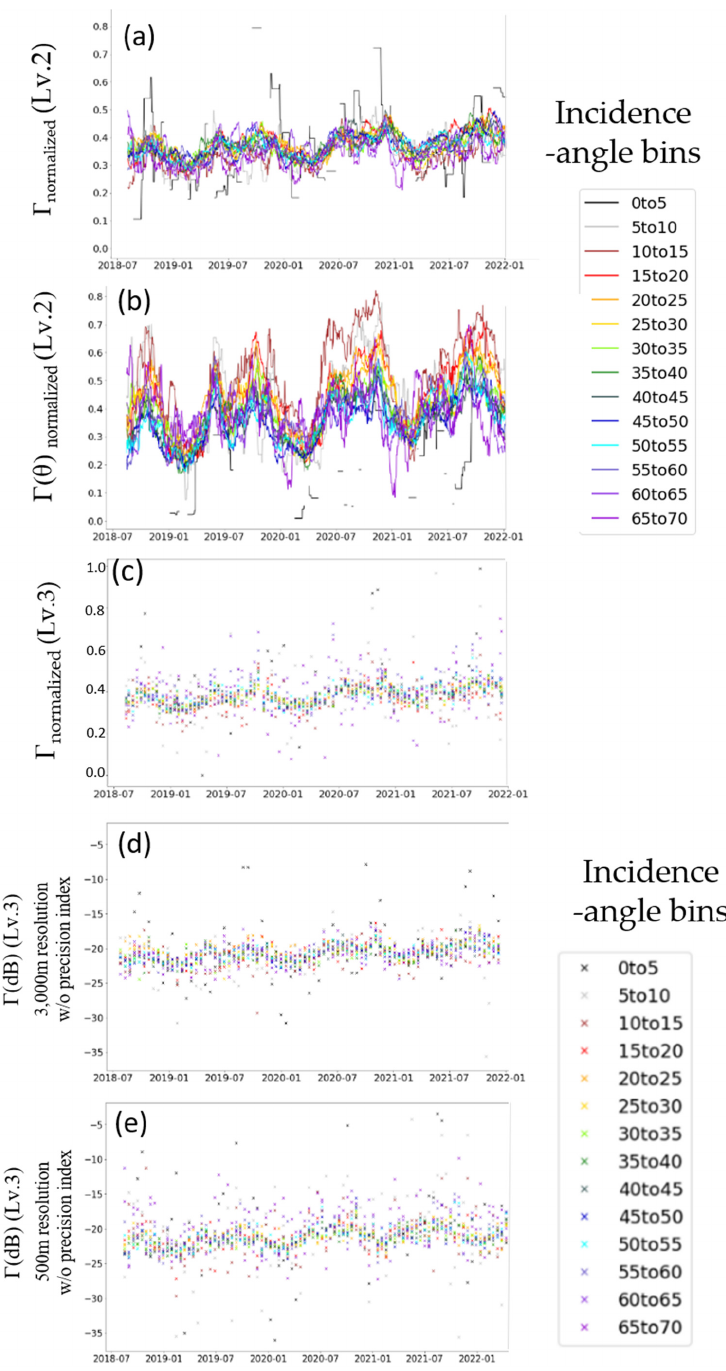
Figure 6. Temporal dynamics of the Lv. 2 daily product with a 30-day moving average (( a ): Γ normalized and ( b ): Γ ( θ ) normalized ) and the Lv. 3 15-day-cycle Kalman smoother product [( c ): Γ normalized (500 m resolution with the precision index), ( d ): Γ (3000 km resolution without the precision index) and e: Γ (500 m resolution without the precision index)]. Each line/plot denotes spatially averaged values over the